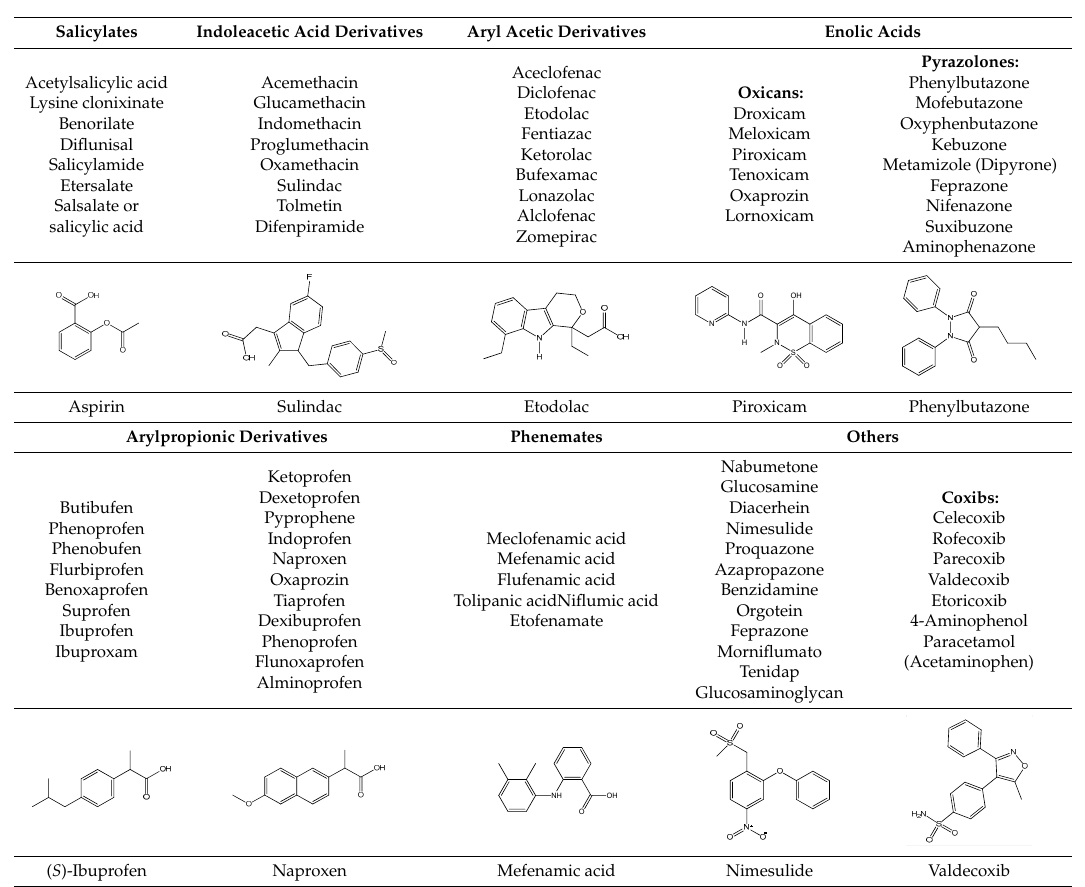
Table 1. Classification of NSAIDs [29].